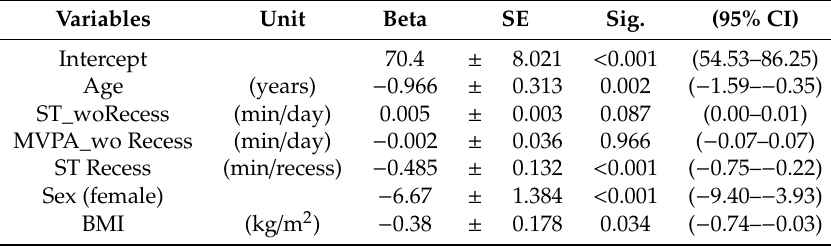
Table 3. Univariate general linear model to estimate VO 2peak predictors.